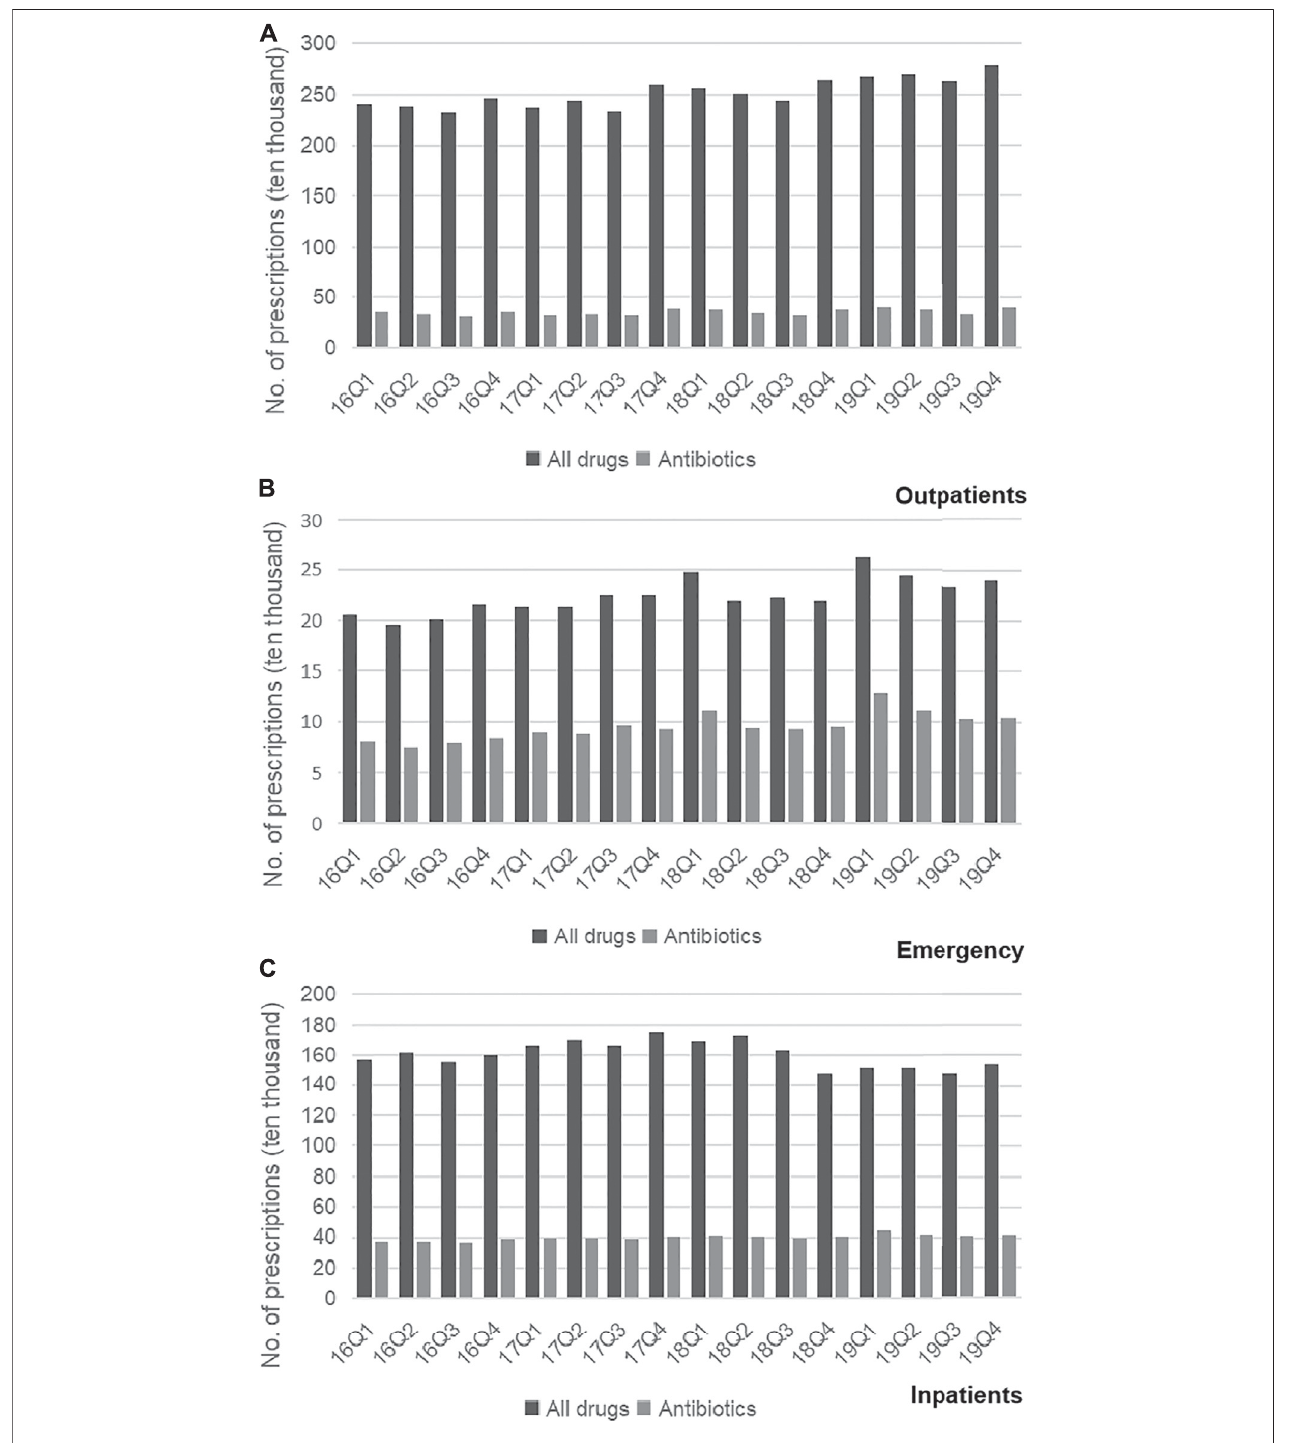
FIGURE 2 | (A) Changes in prescriptions of drugs in Outpatients, 2016 – 19. (B) Changes in prescriptions of drugs in Emergency, 2016 – 19. (C) Changes in prescriptions of drugs in Inpatients, 2016 – 19.